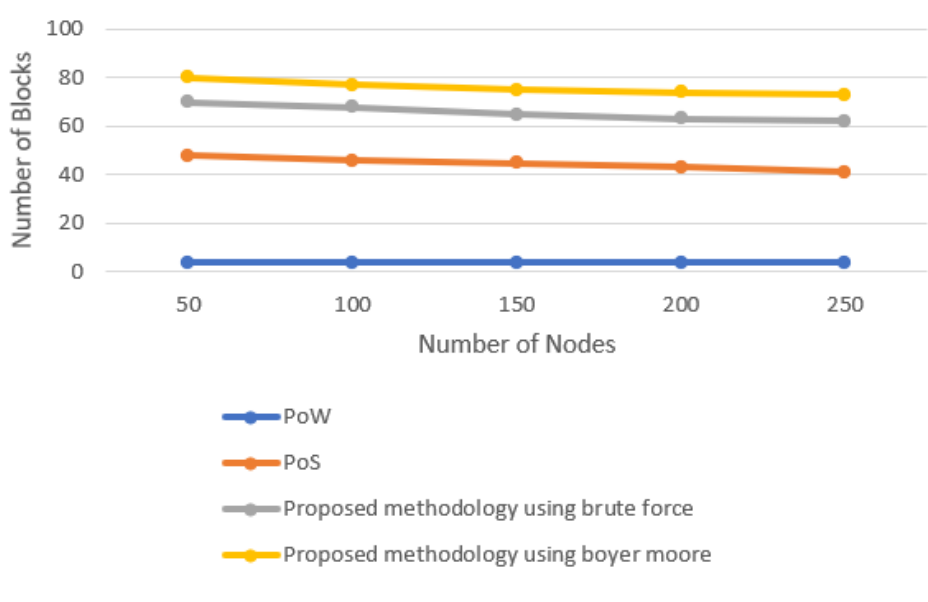
Figure 6. Block generation for 40-min time interval.